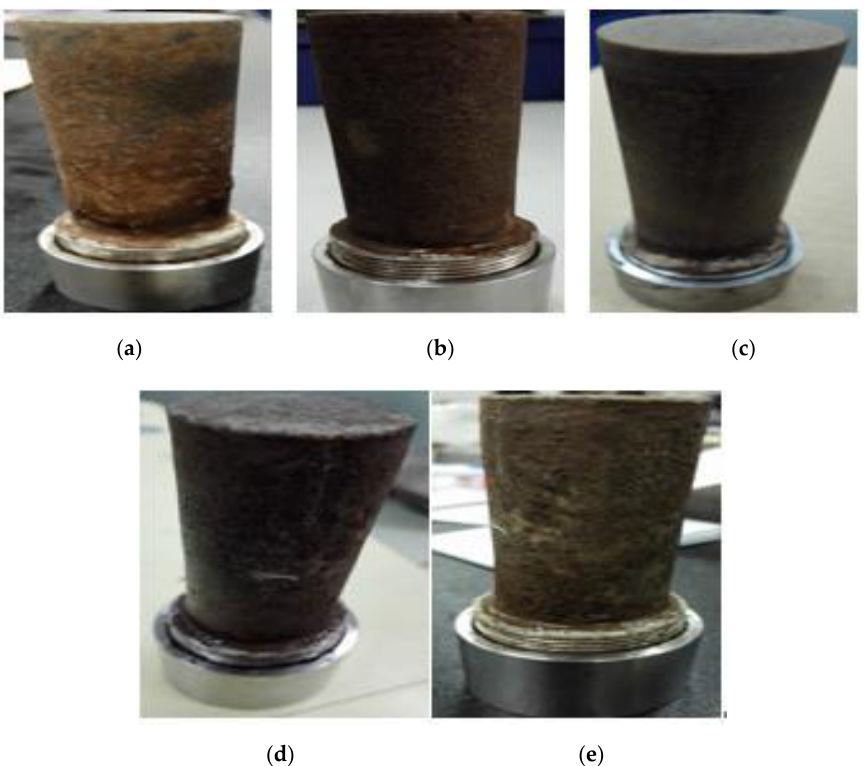
Figure 5. Morphology of core after washing. - Figure 5 ( a - e ) shows the appearance of core in Figure 4 ( a - e ) after